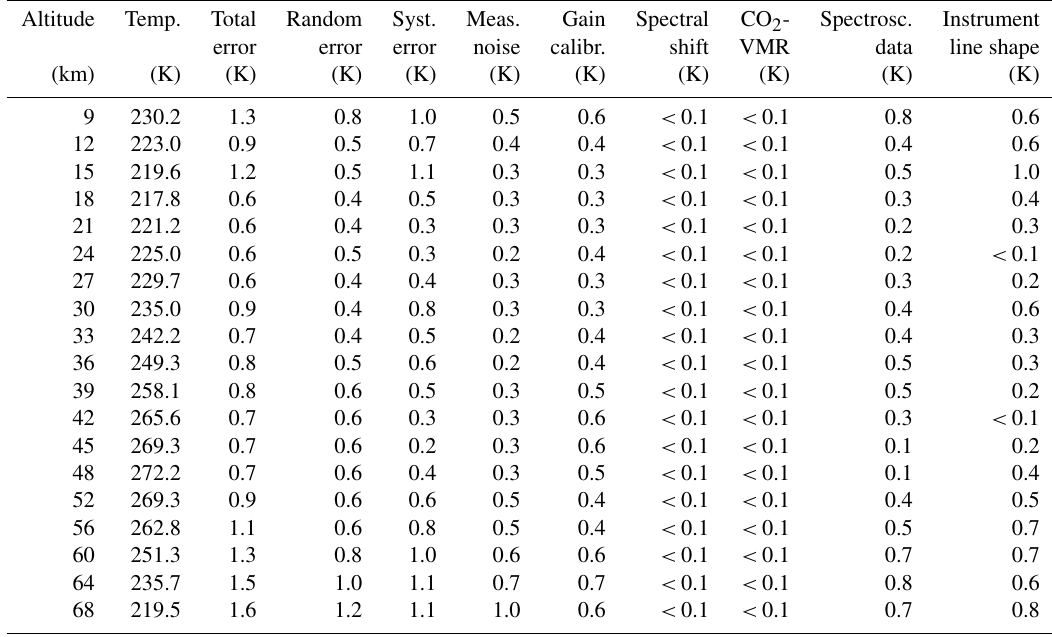
Table A9. RR data temperature error budget for southern midlatitude summer day. All uncertainties are 1 σ . Altitude